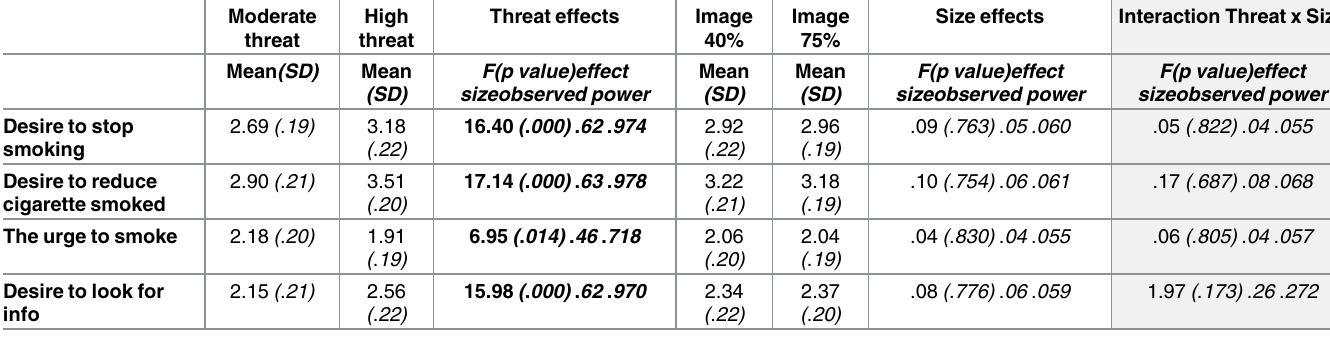
Table 4. Effects of threat level and image size on behavioral